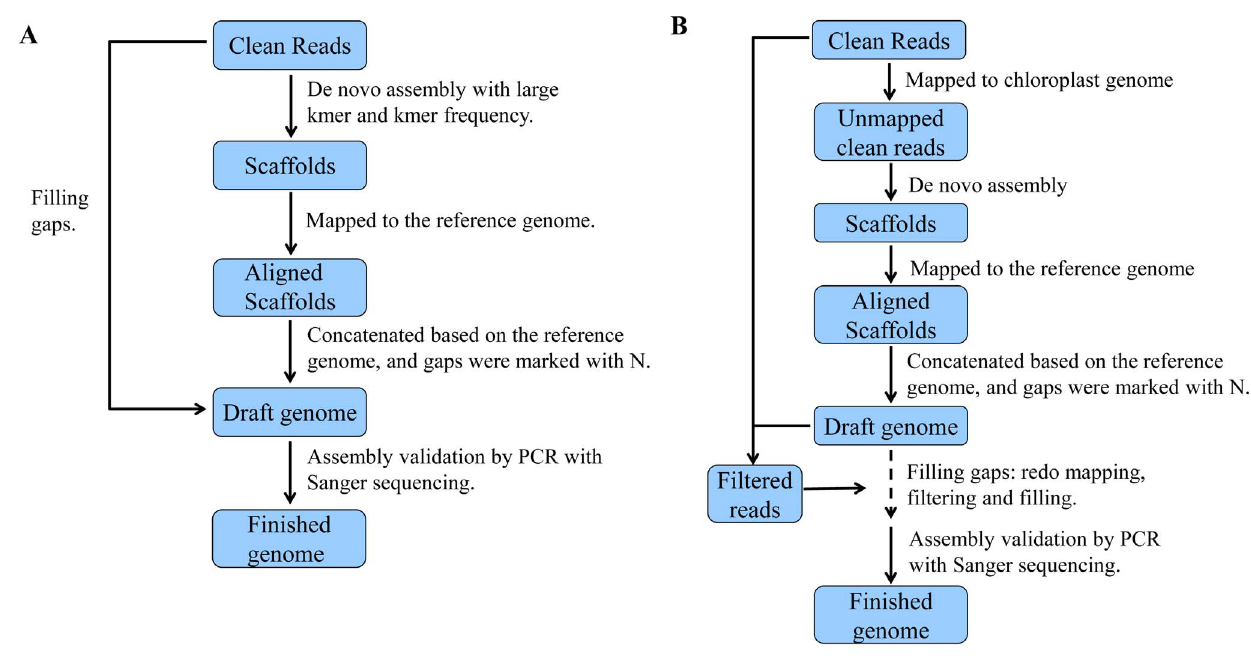
Figure 2. Flowchart showing the major steps of de novo assembly employing TSA. A) First step: assembly of the plastid genome; B) second step: assembly of the mitochondrial genome.